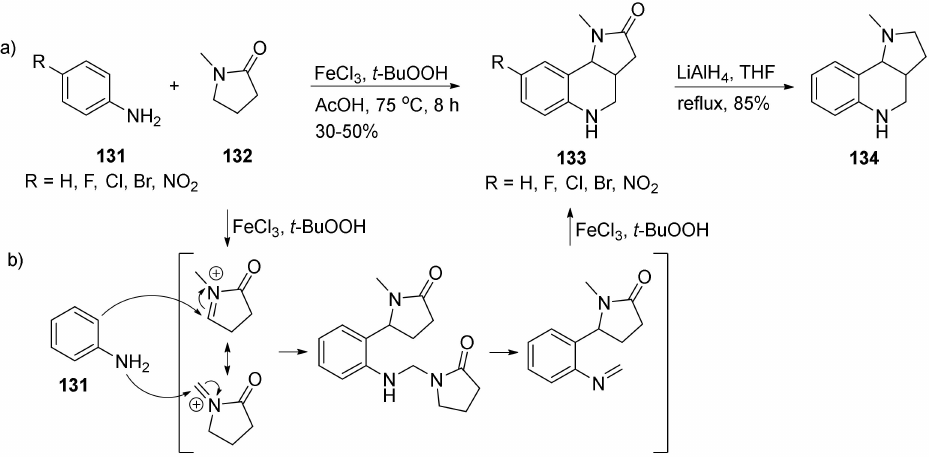
Scheme 21. ( a ) Reaction conditions and ( b ) the proposed mechanism for scaffold assembly by Bao and co-workers.